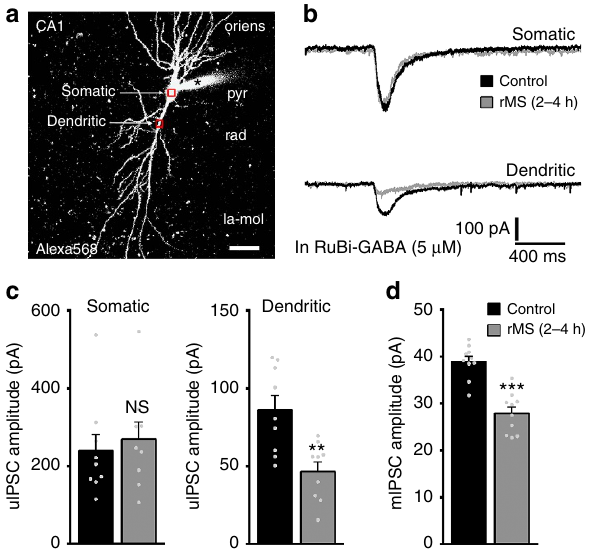
Figure 7 | Flash photolysis of caged GABA discloses that rMS affects predominantly dendritic inhibition. ( a ) Flash photolysis of RuBi-GABA was employed to separately assess dendritic and somatic inhibition in the same set of patched CA1 pyramidal neurons (filled with Alexa568 before recordings; la-mol). Scale bar, 30 m m. ( b ) Representative averaged traces (five consecutive laser-light pulses at 0.1Hz in each region) showing RuBi- GABA-uncaging-evoked somatic and dendritic responses recorded from non-stimulated control cultures and cultures between 2 and 4h after rMS. ( c , d ) Group data of uncaging-evoked inhibitory postsynaptic current (uIPSC) amplitudes ( n ¼ 9 neurons per group; five cultures each; Mann– Whitney test). In the same set of cultures mIPSC recordings confirmed a significant reduction in the mean mIPSC amplitude of CA1 pyramidal neurons (note: internal solution contained higher [Cl (cid:2) ] than in Fig. 1h; control, n ¼ 10 neurons; rMS, n ¼ 10 neurons from four cultures each; Mann–Whitney test). Individual data points are indicated by grey dots. Values represent mean ± s.e.m. (** P o 0.01; *** P o 0.001; ns, not significant